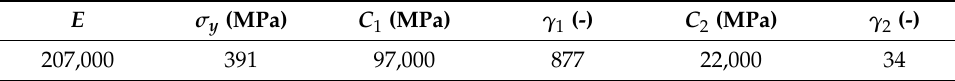
Figure 2. Deformation curve of 51CrV4 material and its approximation by Equation (7). Table 2. Material parameters of the Chaboche model for 51CrV4 material.